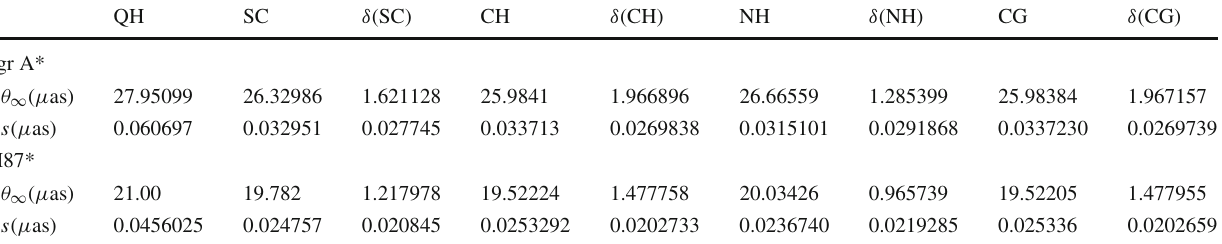
Table 9 The lensing observables θ ∞ , s and r mag for QH, CH, NH and CG at q = − 0 . 139322 and Schwarzschild black hole (SC) by mod- elling them as Sgr A* and M87*. The deviation of these black holes